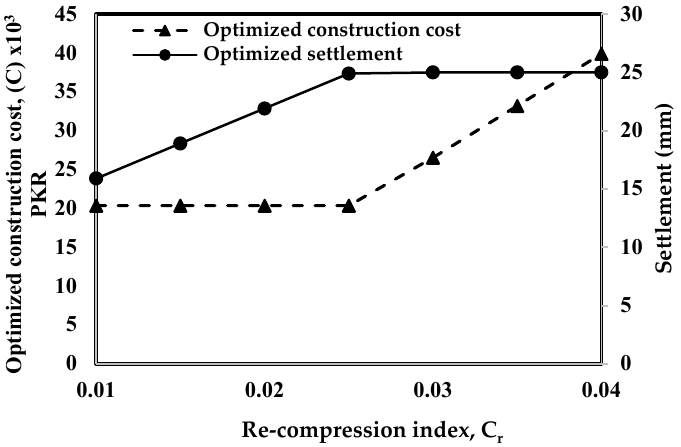
Figure 6. Effect of re-compression index on optimized construction cost.